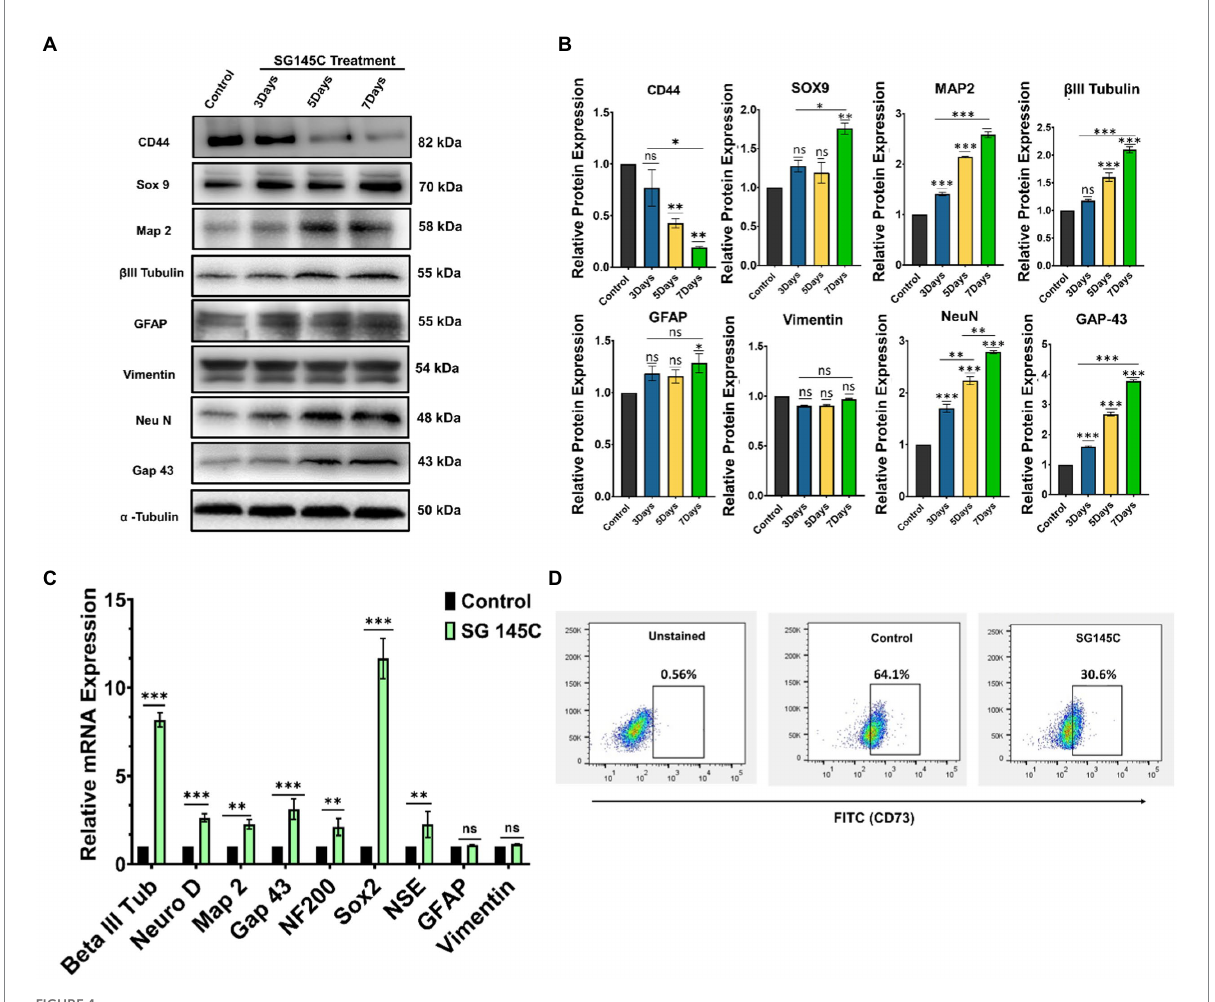
FIGURE 4 Characterization of the differentiated neurons. (A) . Immunoblot analysis to check the expression of neuronal marker proteins at various time points after treatment with 5 μ M SG-145C followed by its (B) densitometric analysis. (C) qPCR analysis reveals the expression pattern of the neuronal marker genes in the transdifferentiated neurons after the treatment with SG-145C. (D) FACS analysis reveals the reduction in mesenchymal stem cell marker CD73 after differentiation. Significance was calculated using one-way Anova for Western Blots and student’s unpaired t -test for qPCR. * p < 0.05; ** p < 0.01; *** p <